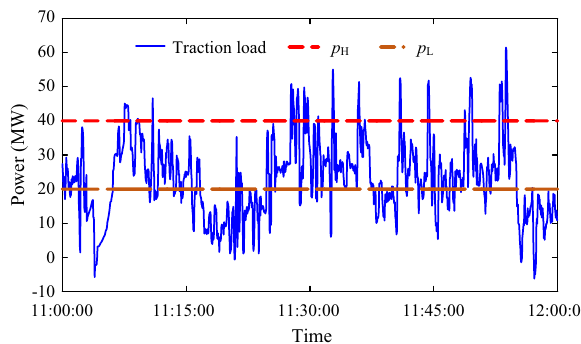
Fig. 4 An actual load power profile of